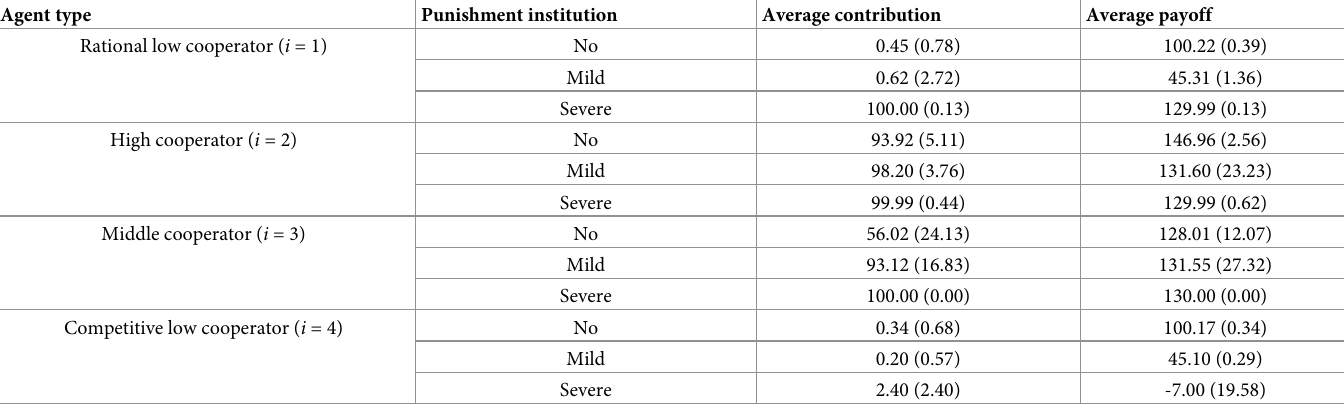
Table 5. Contributions and payoffs under exogenous punishment in the last 20 periods of 100 simulation